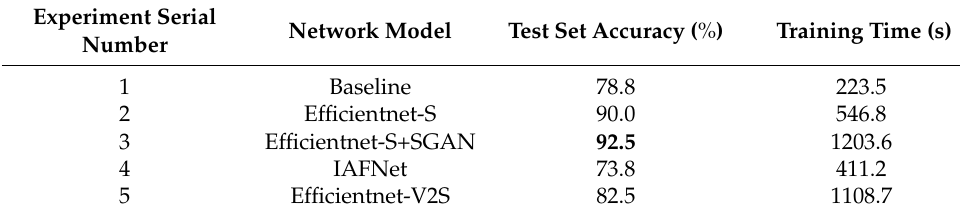
Table 5. Experimental results of different models.